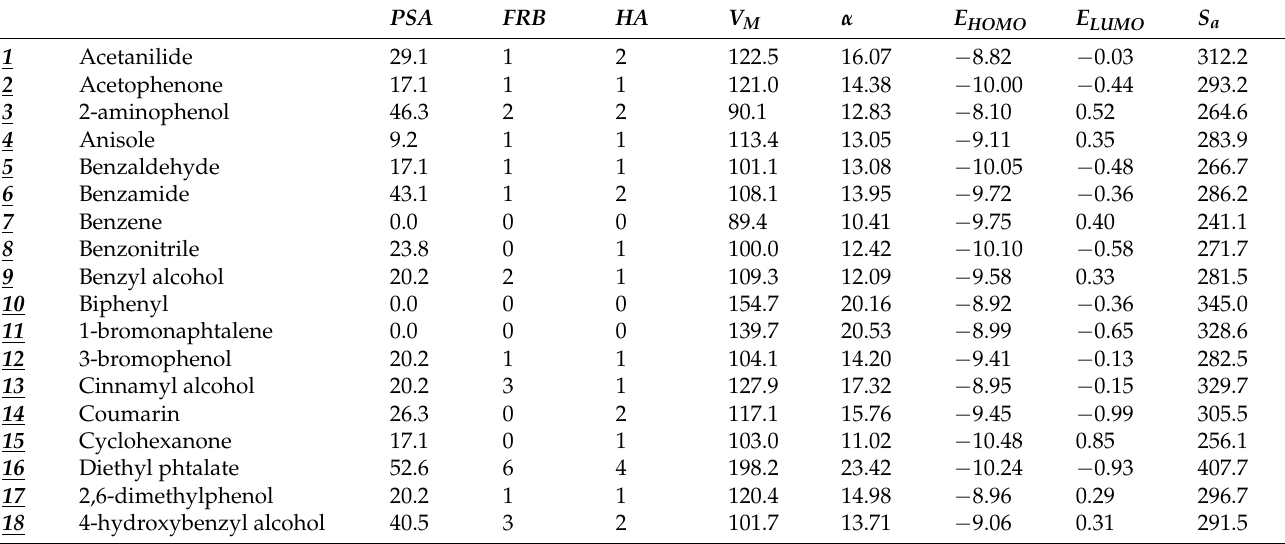
Table 2. Calculated descriptors for compounds 1 to 160